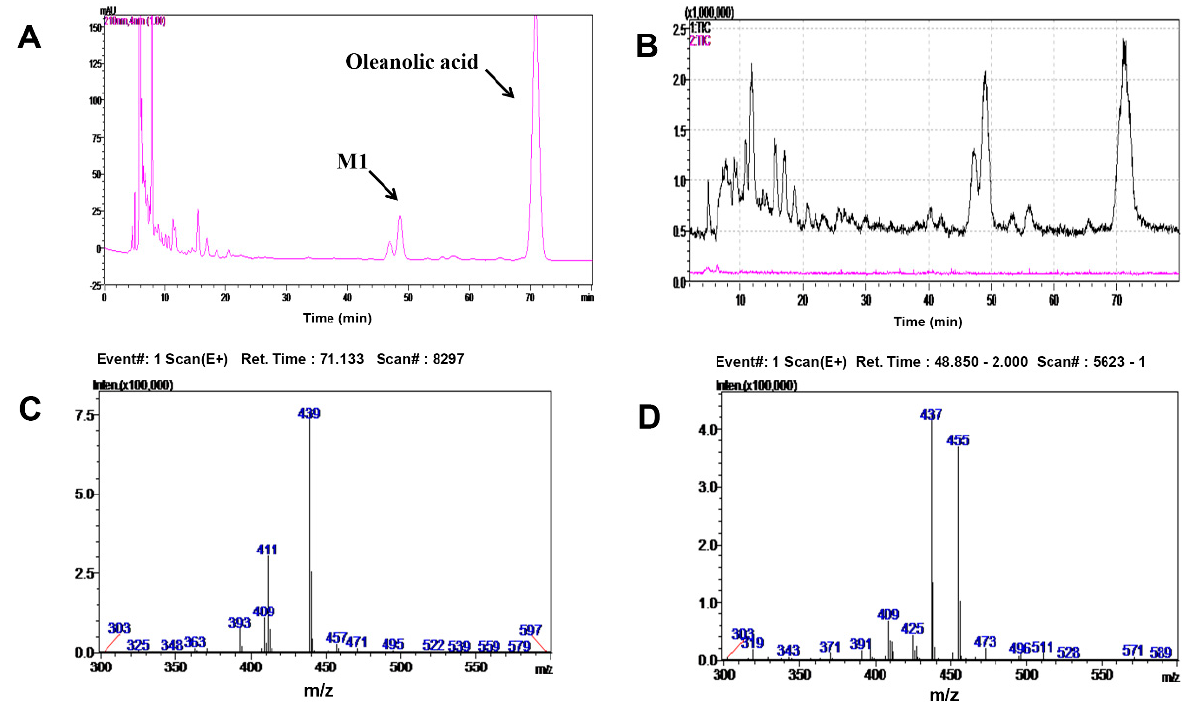
Figure 3. LC – MS spectra of a major metabolite of OA produced by CYP3A4. The LC – MS chromatogram of OA and its major metabolite ( A ) was observed at A 210 , and the total ion current (TIC) profile of the metabolites produced by CYP3A4 ( B ) is shown. The MS spectra showing the protonated molecular ions of OA ( C ) and its major metabolite ( D ) were 439 and 455, respectively.